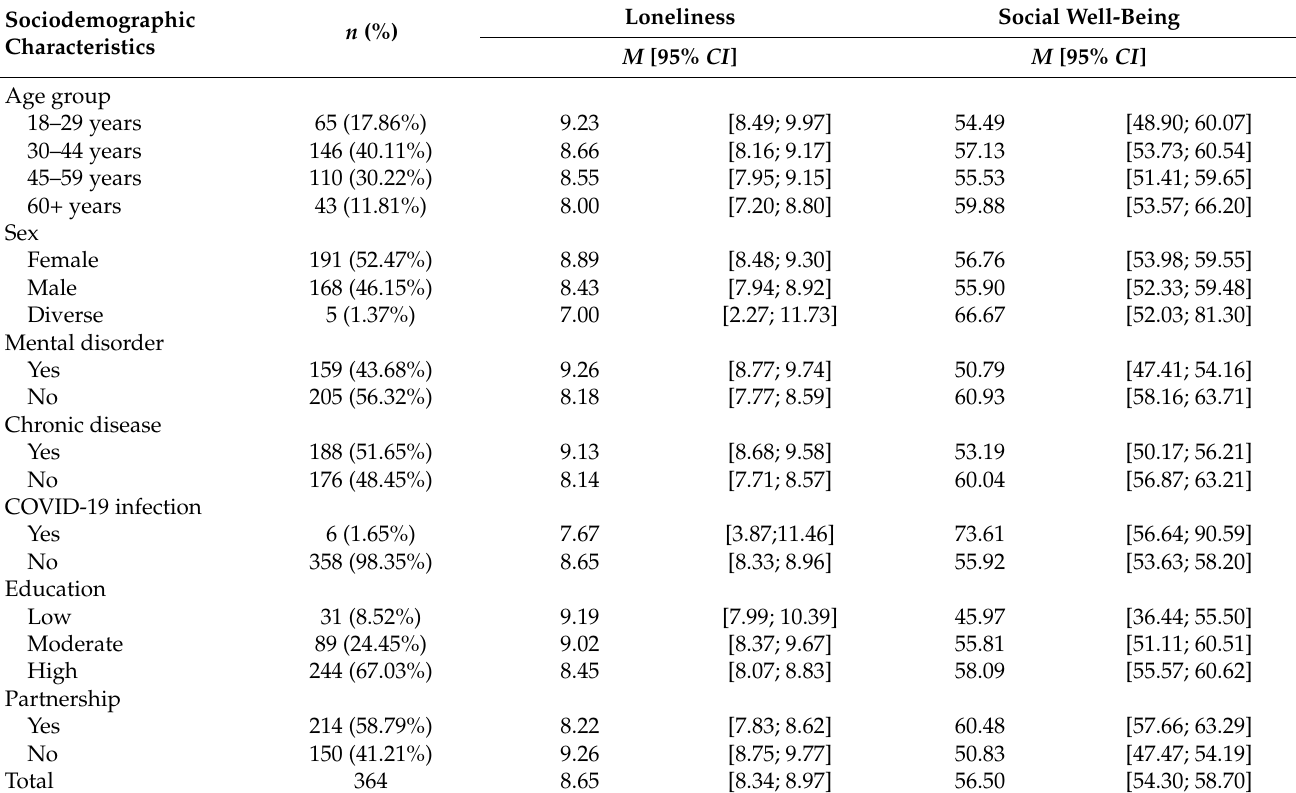
Table 1. Self-reported perceived loneliness and social well-being grouped by sociodemographic characteristics ( n = 364).